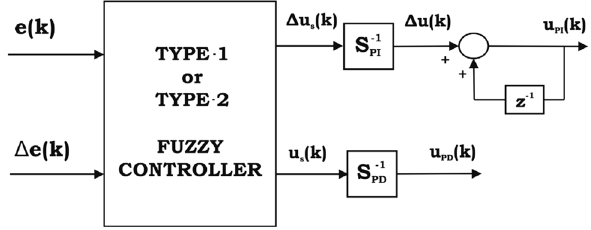
Fig. 1 Block diagram of a typical fuzzy PI/PD